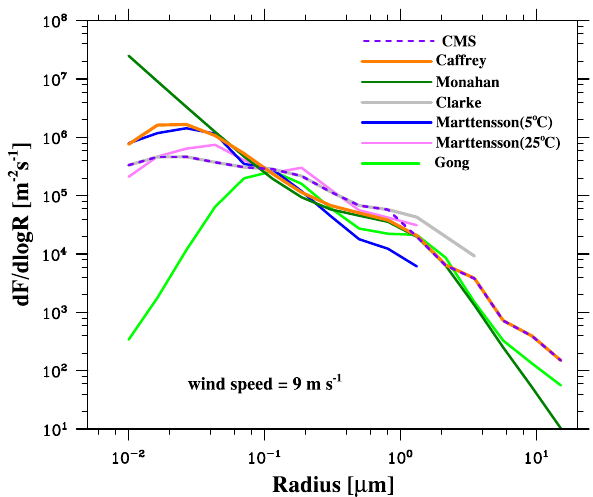
Fig. 1. The number fluxes from several sea-salt source functions as a function of dry radius. All of the source functions except for Gong are corrected for gravitational sedimentation following Hoppel et al.